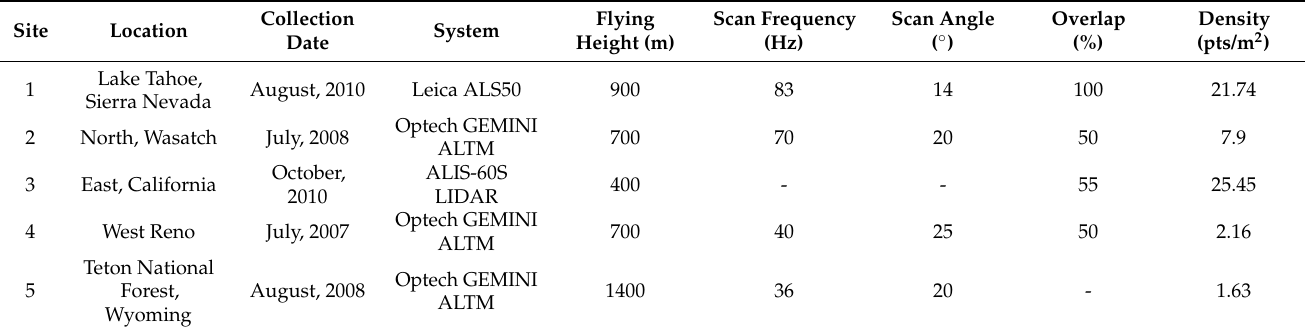
Table 1. Data collection summaries of the five forested sites.